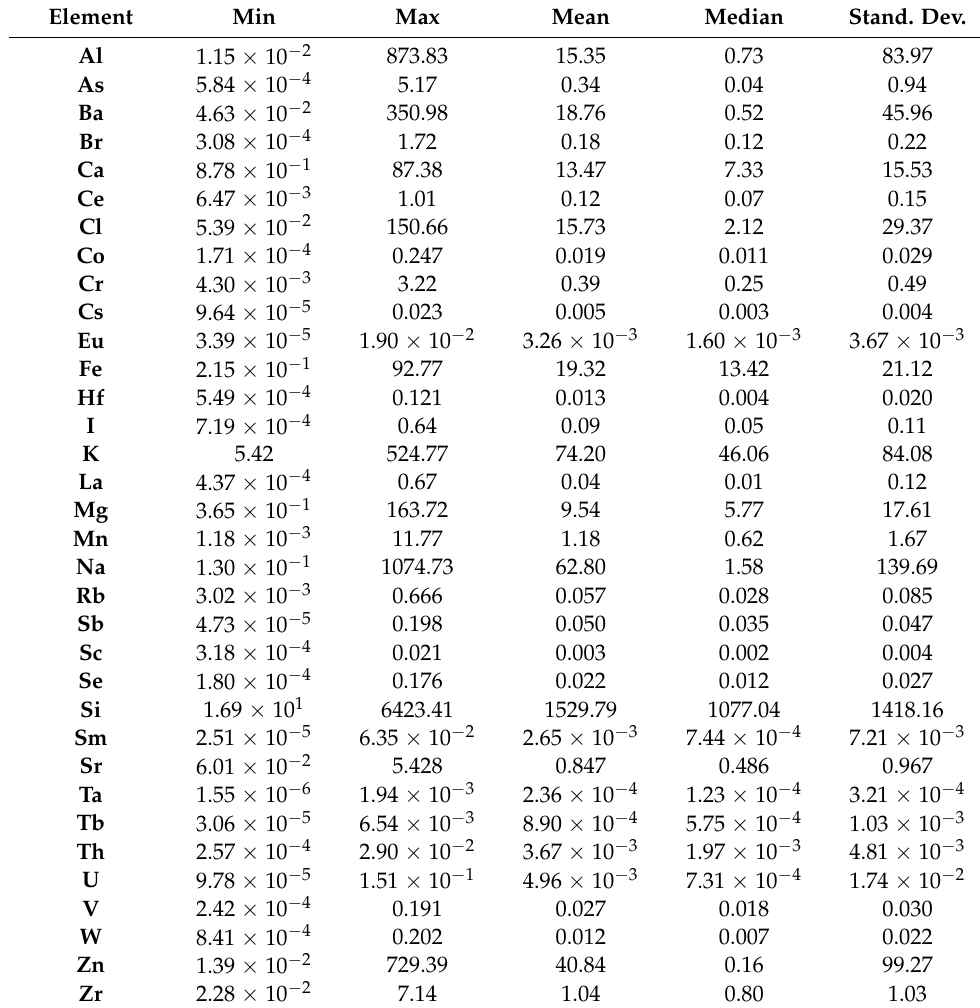
Table 2. Synoptic table (minimum, maximum value, mean, median and standard deviation) of elements concentration (ng · m − 3 ) determined in the PM 10 using INAA.